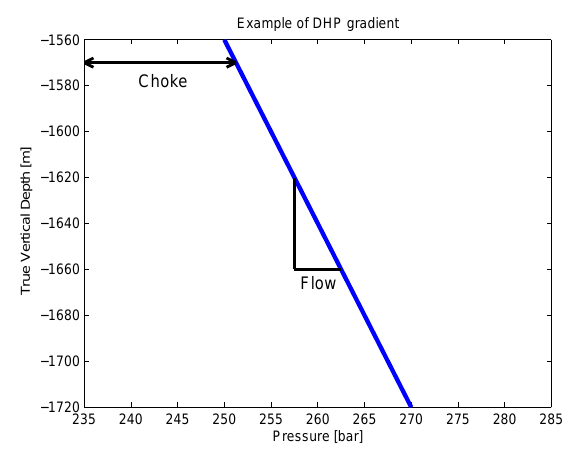
Figure 2: Choke and flow effect illustration. Pressure vs.